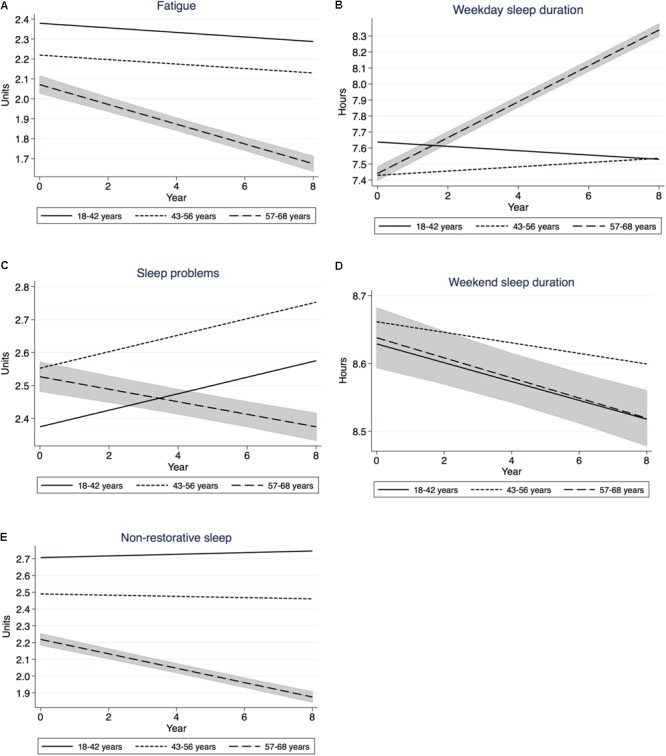
(A–E) Trajectories across 8 years for the main variables in three age groups. 95% Confidence interval for the oldest group. Mixed model regression. Note difference in scale for sleep duration variables.